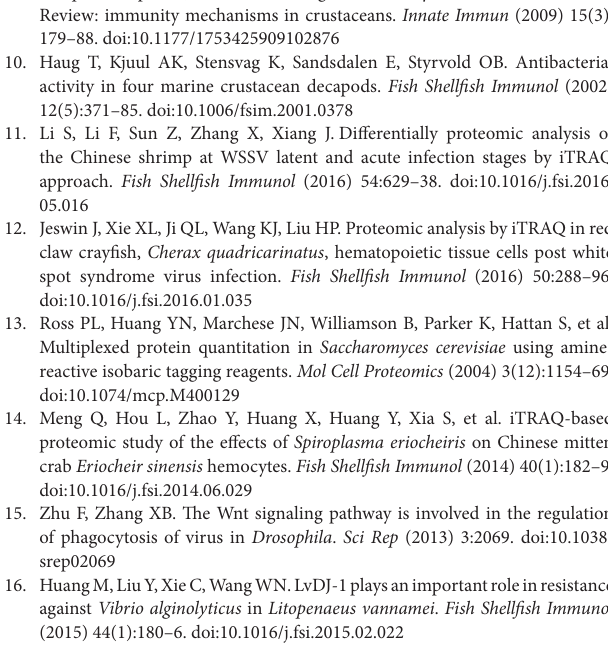
FigUre s1 | (a) Kyoto Encyclopedia of Genes and Genomes (KEGG) pathway classification of differential expressed proteins (more than 1.2-fold) from white spot syndrome virus group vs control group. (B) KEGG pathway classification of differentially expressed proteins (more than 1.2-fold) from Vibrio alginolyticus vs control. FigUre s2 | The statistics of gene ontology (GO) enrichment (a) and statistics of pathway enrichment (B) of differentially expressed proteins (more than 1.2-fold) from white spot syndrome virus vs Vibrio alginolyticus